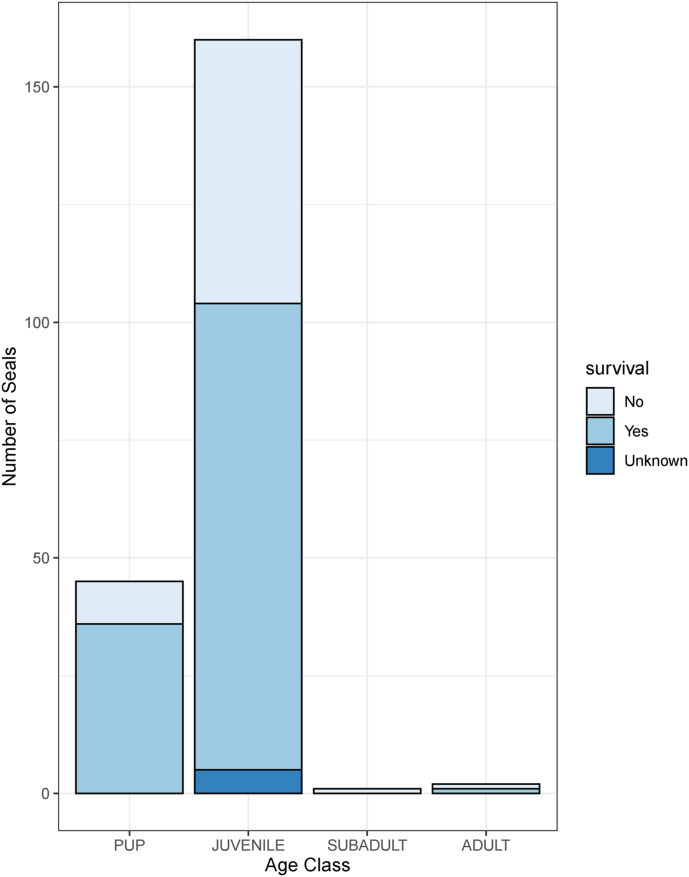
Harbour seal survival in the rehabilitation centre, see file ‘Fig. 1’ (p.8).